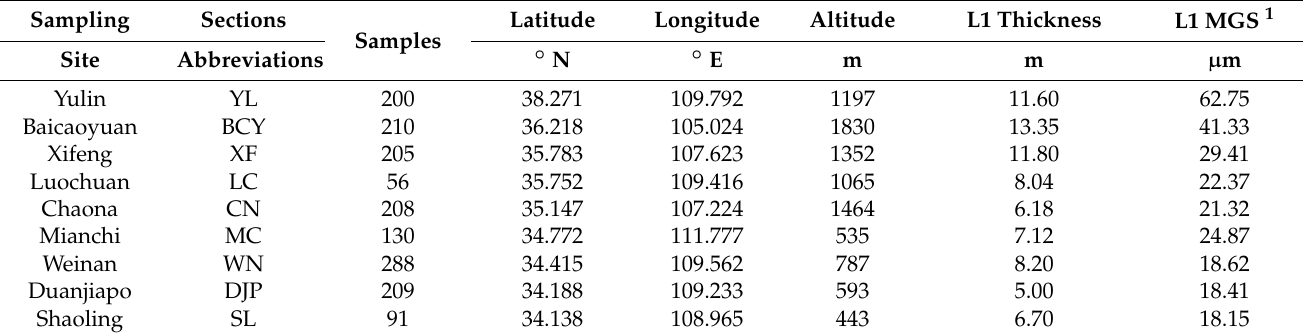
Table 1. Nine last glacial loess sites on the Chinese Loess